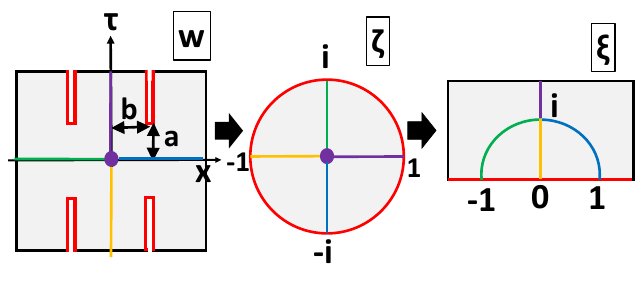
Figure 10 . The conformal map (4.1).